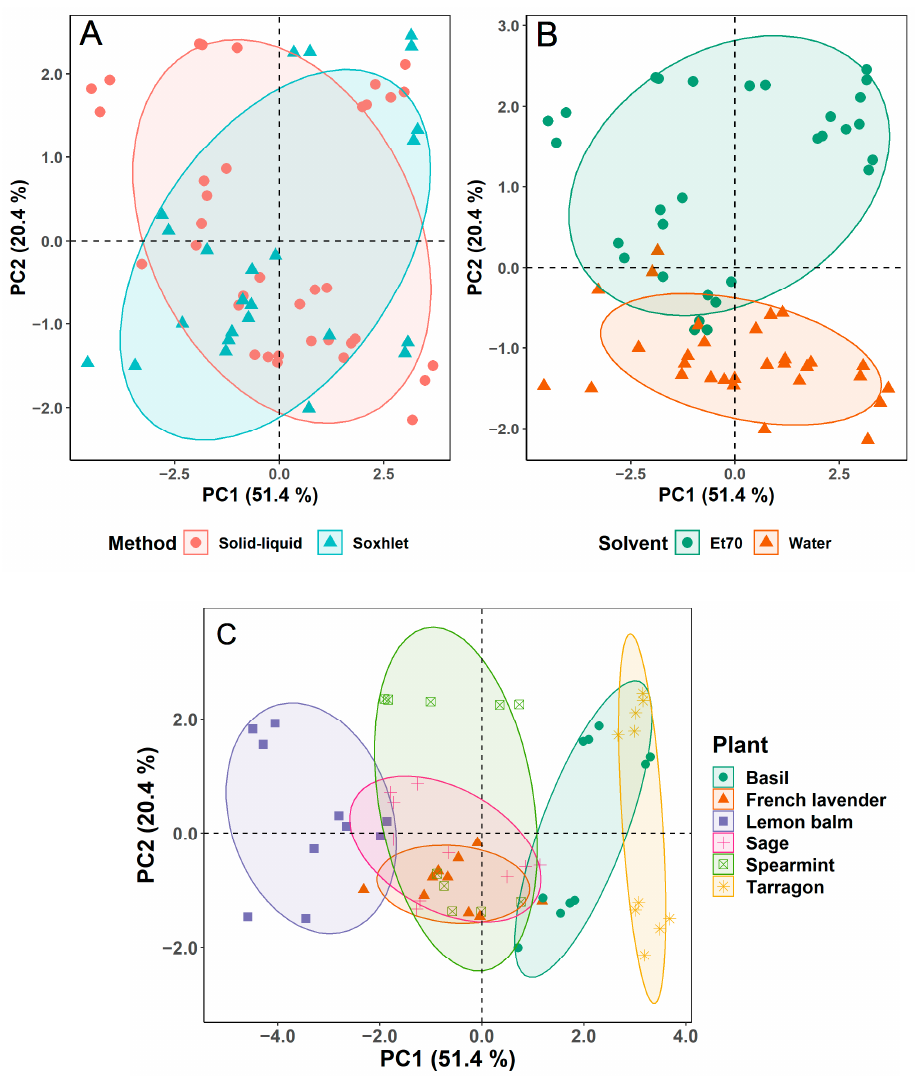
Figure 2. Score plots of the first two components of the principal component analysis (PCA) grouped by extraction method ( A ), solvent ( B ) and plant type ( C ).